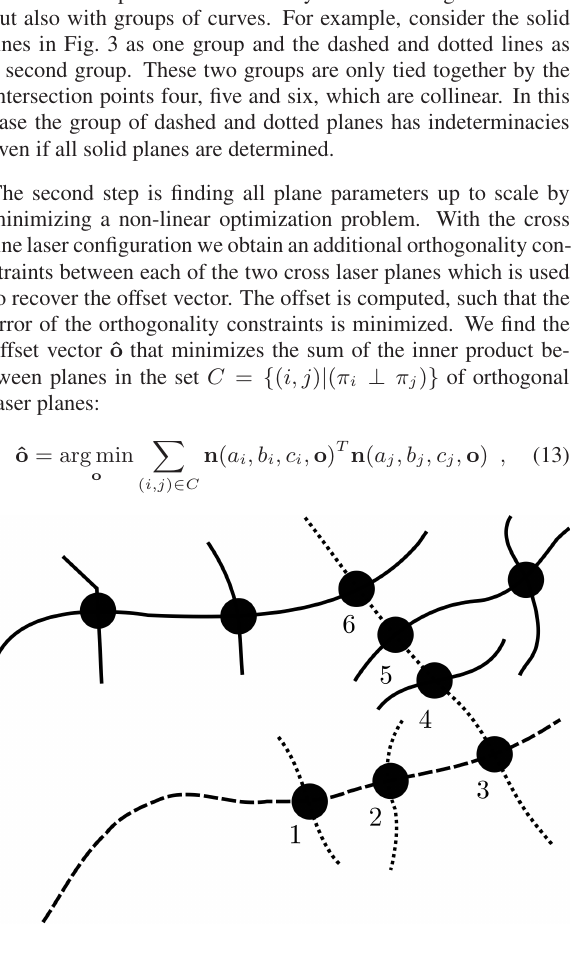
Figure 3: Collinear intersections between laser curves.